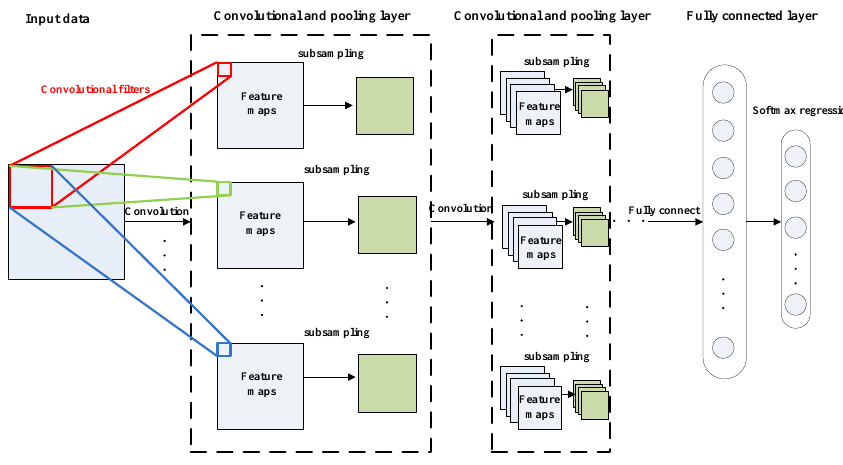
Figure 1. A typical architecture of deep convolutional neural network (DCNN).